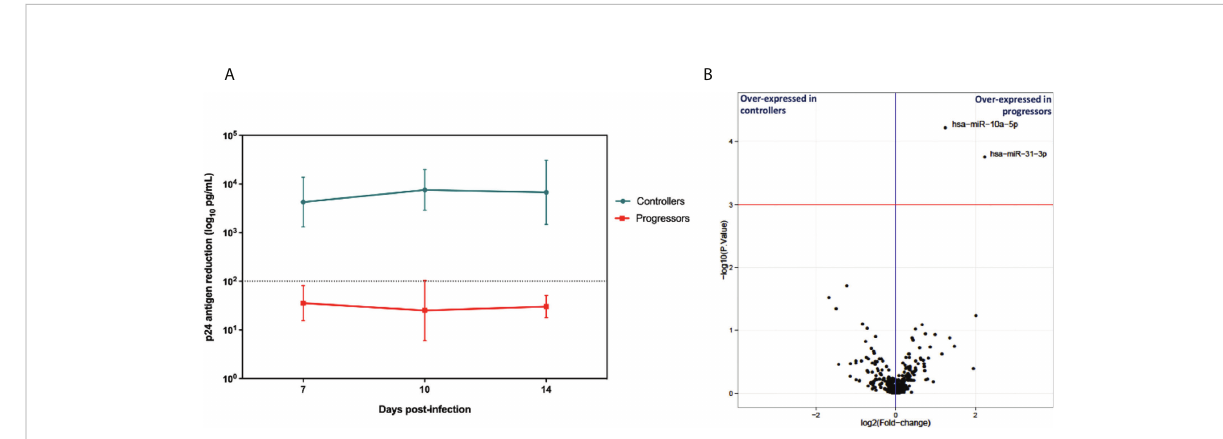
FIGURE 2 (A) Cytolytic activity of CD8 + T cells from EC and CP evaluated by p24 antigen quanti fi cation (n=6 in each group). Depicts the mean and stand deviation of p24 (ng/ml) levels for each patient at the different time points. HIV-suppressive capacity of CD8 + T cells is calculated at the peak of viral replication in CD4 + T cells alone, as the log decrease in p24 production when CD4 + T cells are cocultured with CD8 + T cells. Experiments run in triplicate. (B) Volcano plot depicting log2 of mean fold changes in miRNA expression (X-axis) and -log10 P values (Y-axis).